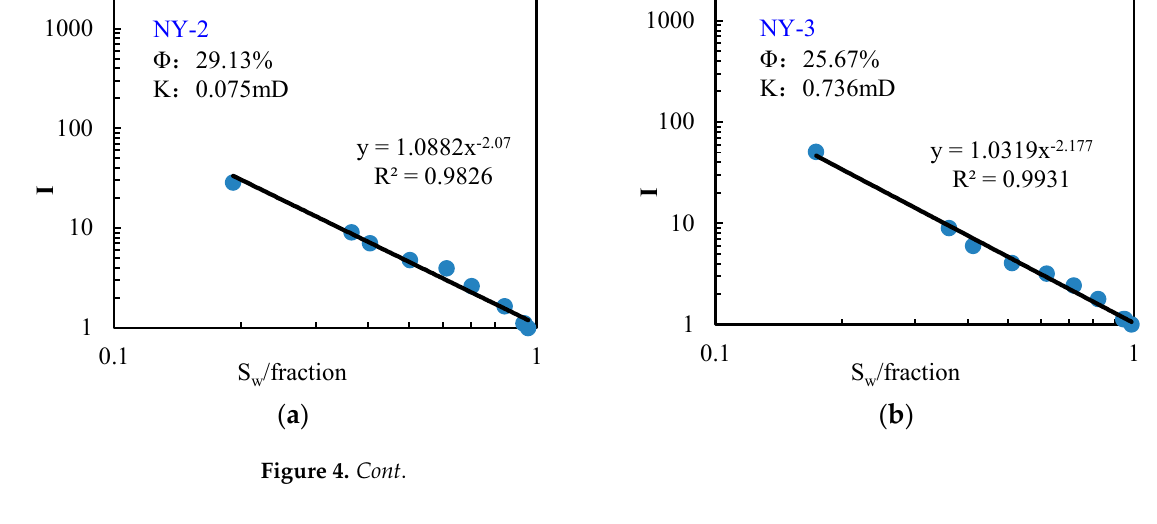
Table 2. Rock electrical parameters of core samples of the Quaternary mudstone biogas reservoir. Rock Electrical Parameters Sample No. F m